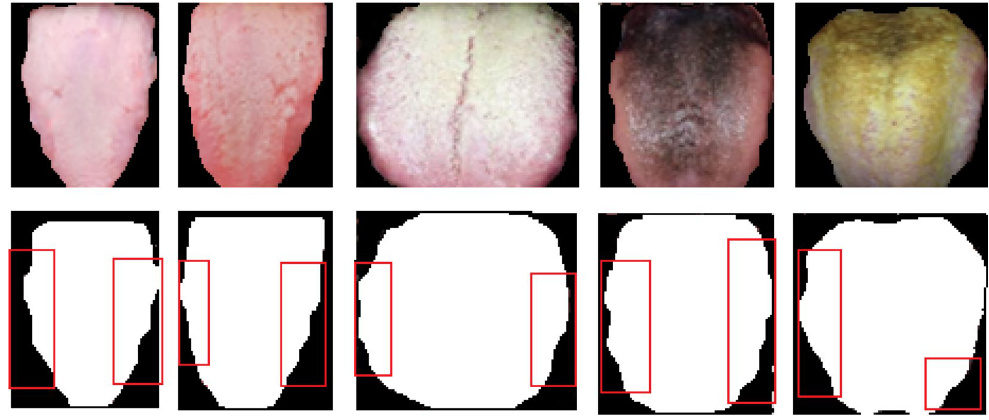
Figure 6. Tooth markings of tongue images.